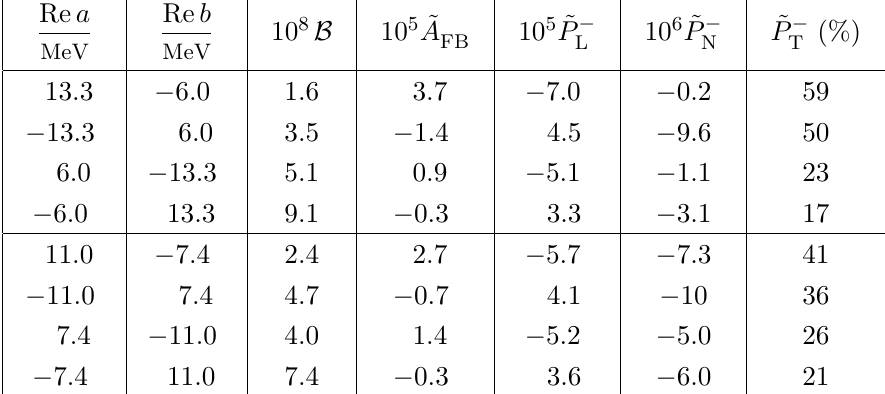
Table 1 . Sample values of the branching fraction B of (cid:6) + ! p(cid:22) + (cid:22) (cid:0) and the corresponding integrated asymmetries ~ A FB and ~ P (cid:0) computed within the SM including the SD and LD L ; N ; T